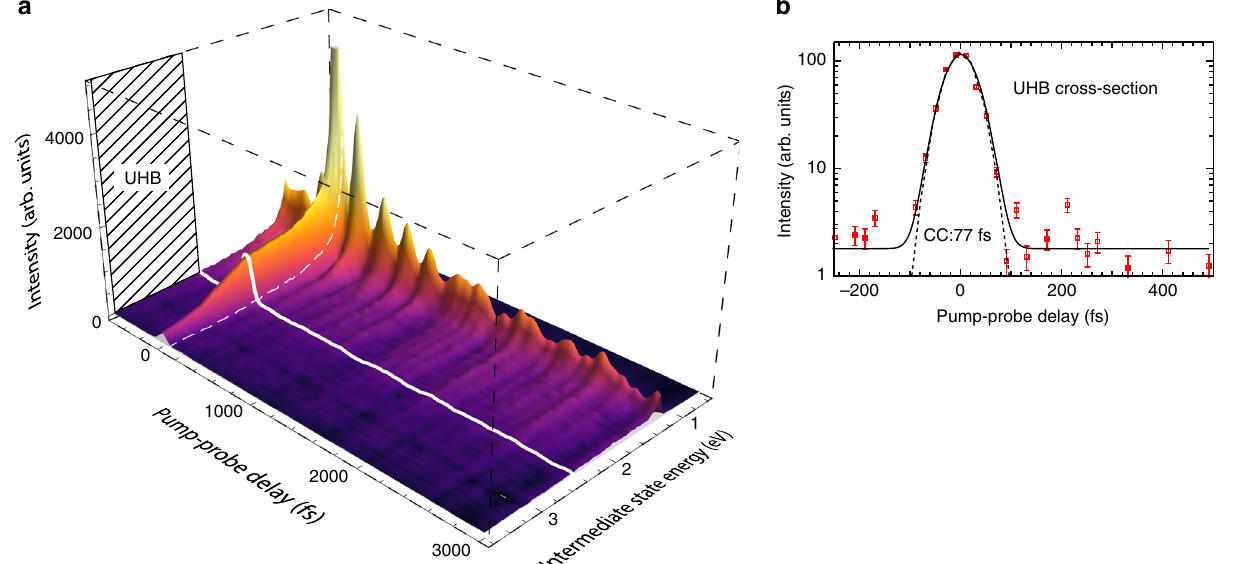
Fig. 2 Time-resolved pump-probe 2PPE data. a Experimental data ( h ν pump = 4.2 eV, h ν probe = 3.4 eV, T = 150 K) for a 9 ML NiO(001) thin fi lm with background subtracted and smoothing using a low-pass fi lter (without fi ltering in Fig. 3). The thick white line indicates the position of the lower edge of the UHB at 2.5 eV. b 2PPE intensity at the UHB bottom versus pump-probe delay. The cross-correlation (CC) of the pump and probe pulses (dashed line) has been determined from the 2PPE signal at higher